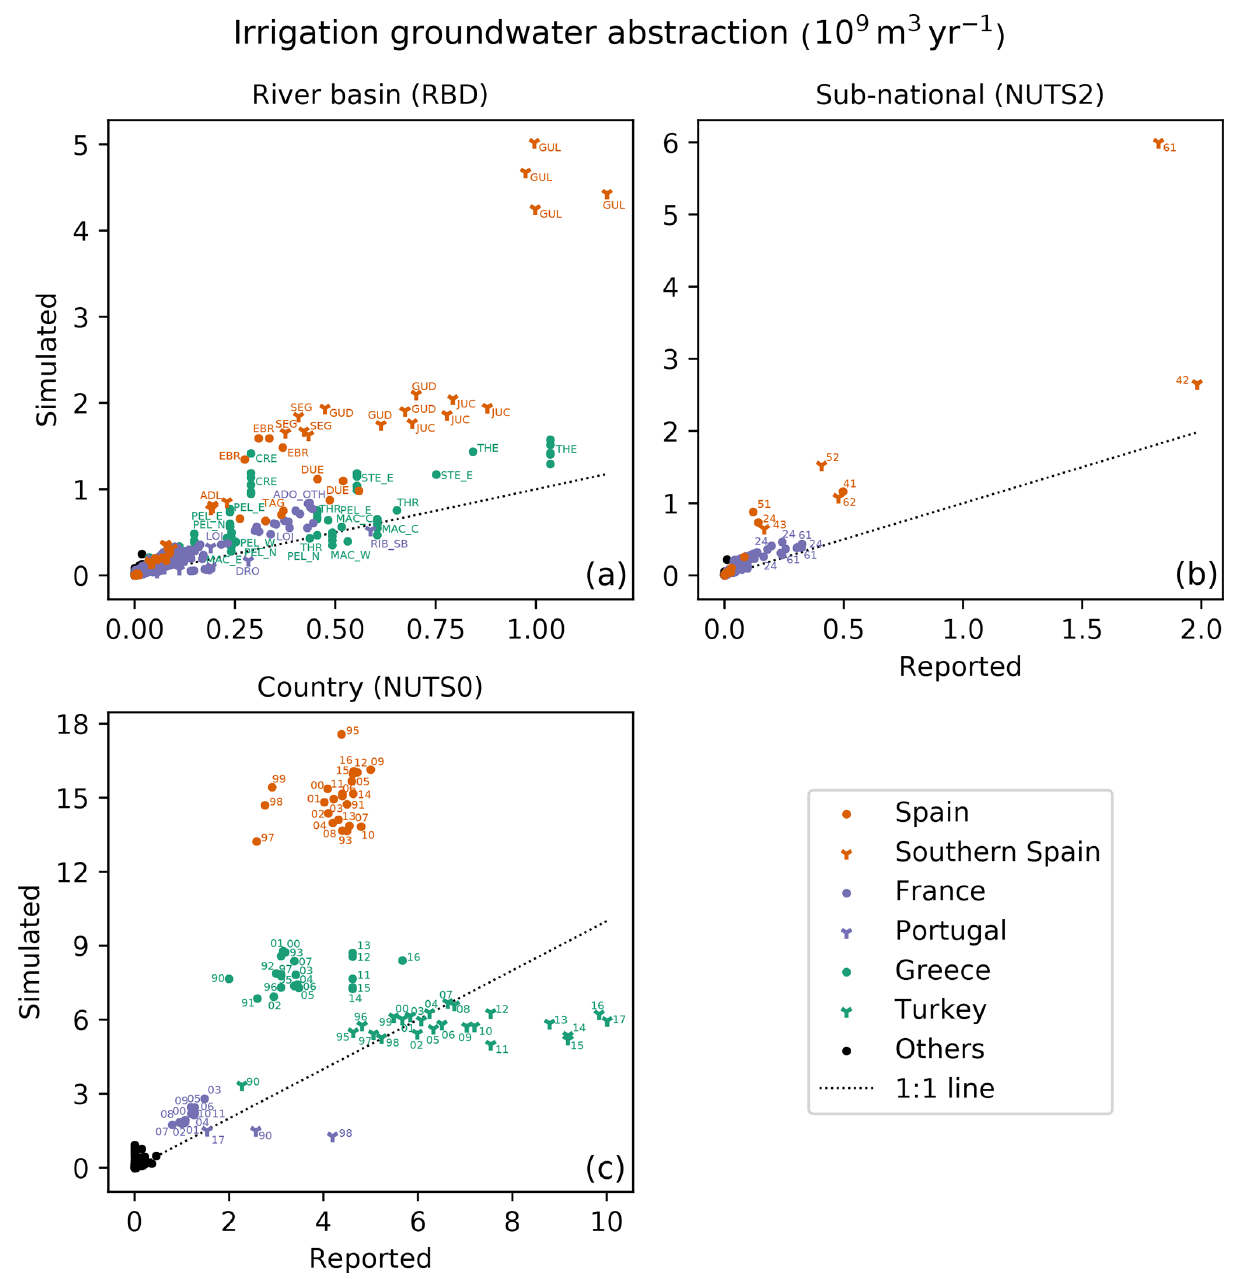
Figure 3. Simulated versus reported groundwater volumes abstracted for irrigation at RBD, NUTS2 and NUTS0 levels (1990–2018). South- ern Spain is defined either as Andalusia (61), Castile-La Mancha (42), Extremadura (43), Murcia (62) and Valencia (52) NUTS2 (b) ; or as Mediterranean Andalusia (ADL), Guadalete (GUA), Guadiana (GUD), Guadalquivir (GUL), Júcar (JUC), Segura (SEG), and Tinto (TIN) RBDs (a) . These definitions overlap over 80% of their union area. Other RBDs (a) : Douro (DUE), Ebro (EBR) and Tagus (TAG) in Spain; Crete (CRE), Eastern Central Greece (STE_E), Eastern and Northern Peloponnese (PEL_E, PEL_N), Eastern, Central and Western Mace- donia (MAC_E, MAC_C, MAC_W), Thessalia (THE) and Thrace (THR) in Greece; Douro (DRO) and Tagus (RIB_SB) in Portugal; Adour, Garonne, Dordogne, Charente and Aquitaine coastal streams (ADO_OTH) and Loire, and the coastal rivers of Vendée and Bretagne (LOI) in France. Other NUTS2 (b) : Aragon (24), Catalonia (51) and Castile and Leon (41) in Spain; Centre (24) and Aquitaine (61) in France. NUTS0 data points (c) are labelled by year of